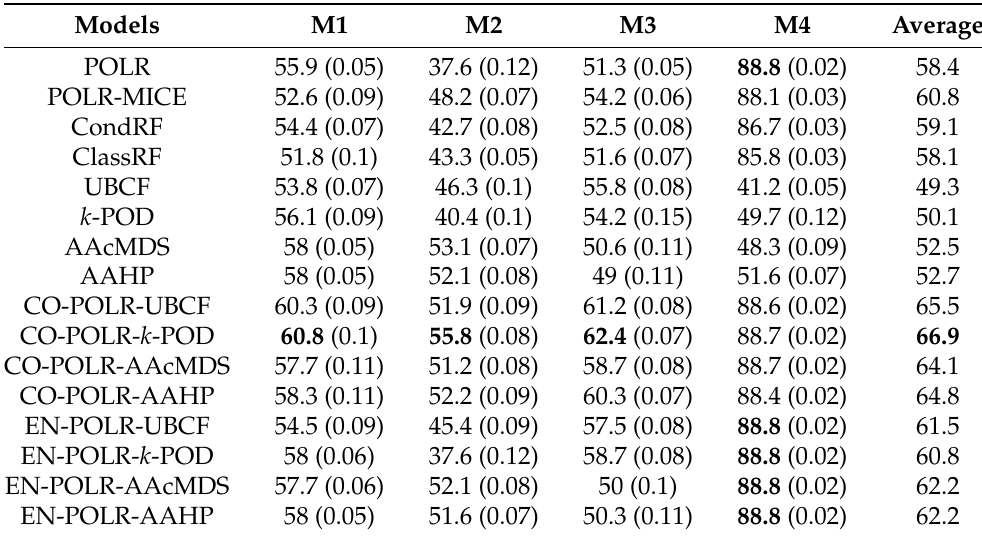
Table 4. Mean and standard deviation, in brackets, of accuracy (percentage) over 10 simulations of the classifiers for the different models of Scenario 2 and their average. The maximum value in each column appears in bold.